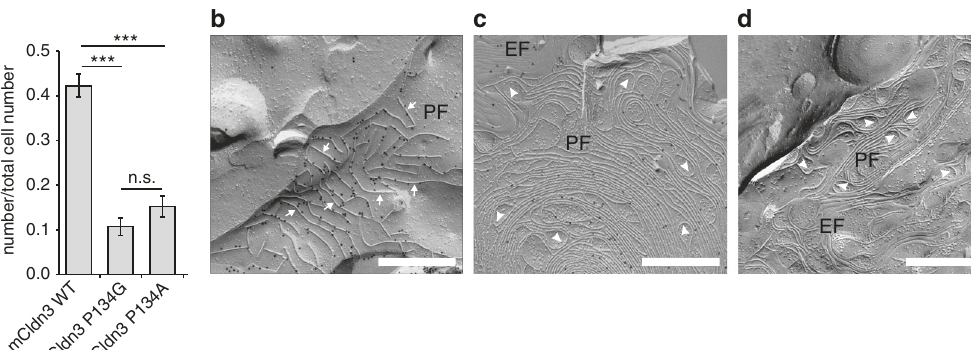
Fig. 5 Morphology and adhesivity of TJ strands formed by mCldn3 with a different TM3 structure. a Adhesive property of TJs formed by a stable SF7- derived cell line expressing mCldn3. Dissociation assay showed that TJs formed by mCldn3 P134G or P134A had stronger adhesivity than TJs of mCldn3 WT ( n = 18/group). Results from three distinct clones are shown as means ± SEM. P -values were calculated using a two-tailed independent t -test, and P < 0.05 was considered signi fi cant. n.s., not signi fi cant; *** p < 0.001. b – d Representative electron microscopic images of freeze-fracture replicas of TJ strands of mCldn3. b TJ strands consisting of wild-type mCldn3 appear as straight strands (arrow). c TJ strands consisting of mCldn3 P134G appear as curvy strands with many hairpin curves (arrowhead). d TJ strands consisting of mCldn3 P134A appear as curvy strands with many hairpin curves. PF